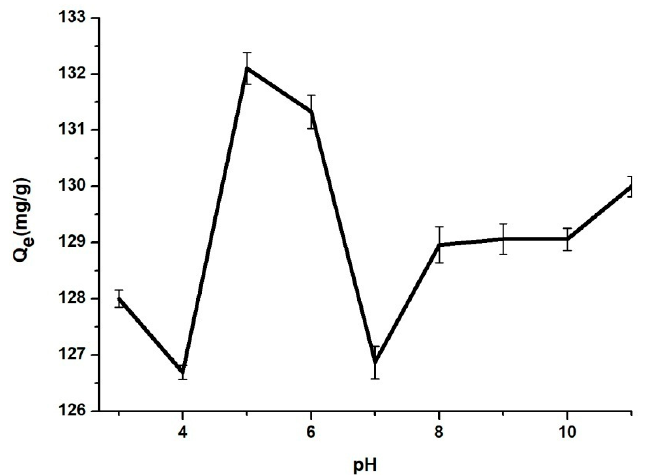
Figure 6. Adsorption of BZC at different pH values onto MSN.